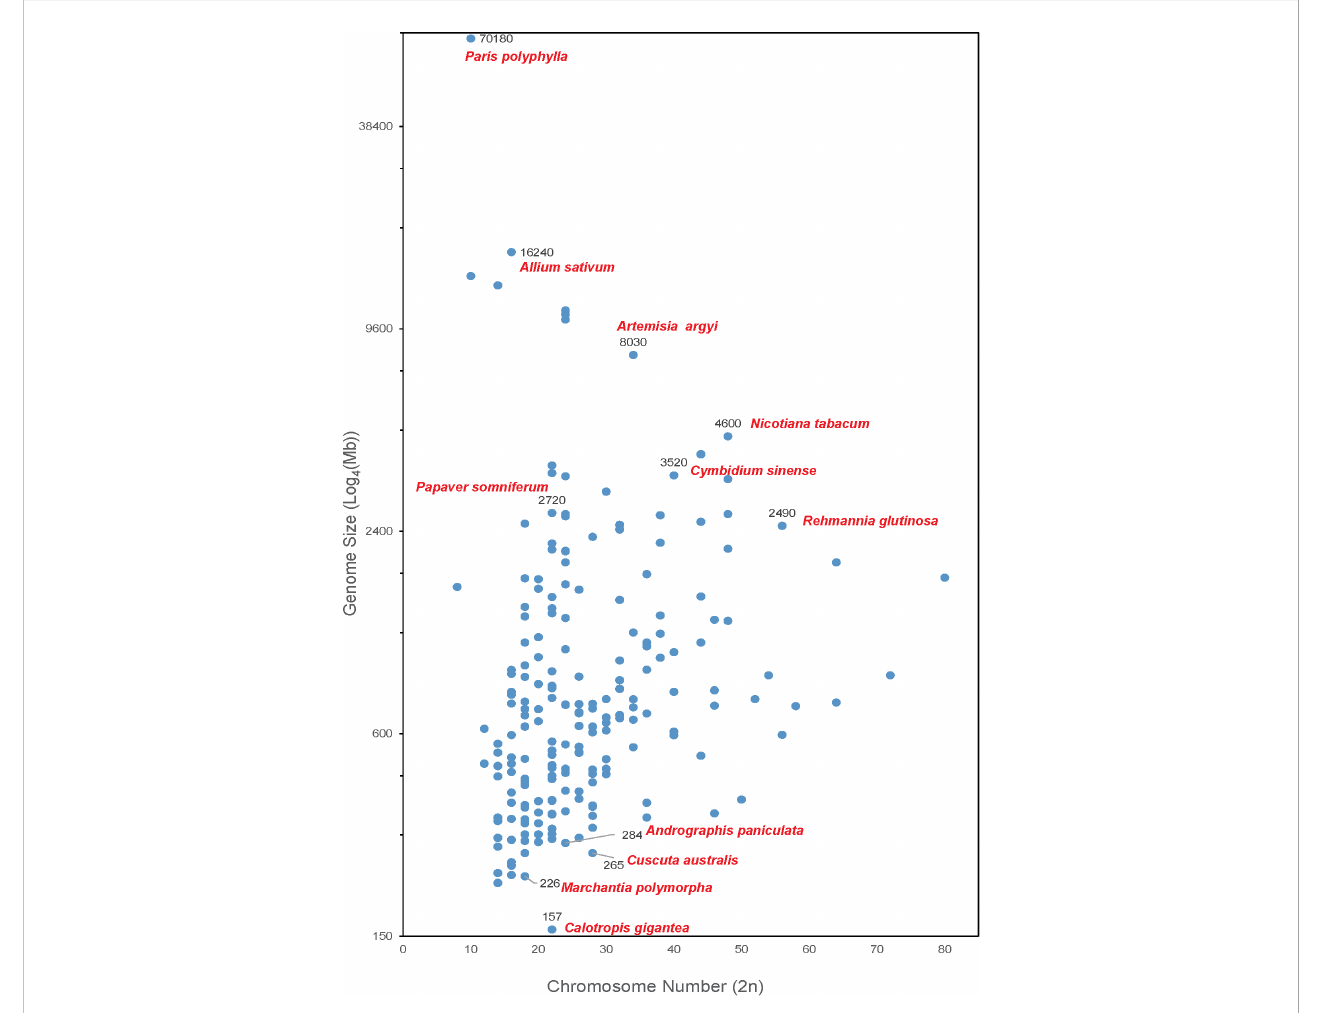
FIGURE 1 Medicinal plants with complete genome sequencing. The X-axis shows the chromosome number of a medicinal plant genome. The Y-axis represents the genome size (Log 4 (Mb)) of each